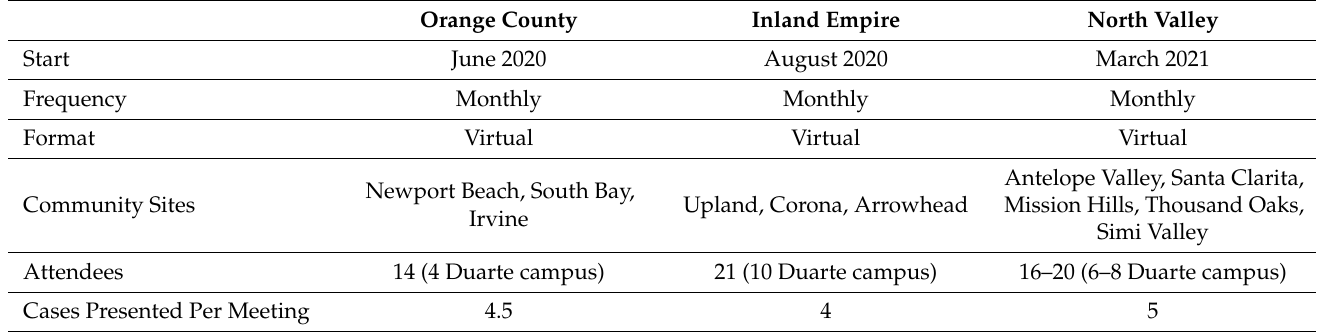
Figure 6. Tumor Board Attendance Over 3 years: 1 January 2019 to 31 December 2021. Table 4. Details of comprehensive case discussion